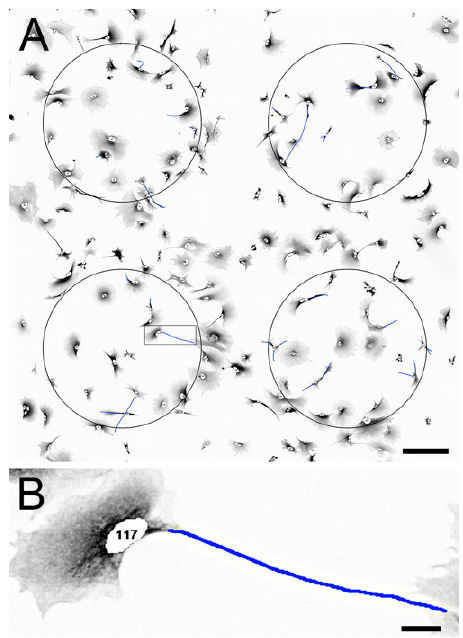
Figure A2. Grayscale image of the signal corresponding to the β -III tubulin channel of β -III tubulin and NeuN/Fox-3 doubly immunolabeled cells. Circles depict sampling areas (ROI). Traced neurites located with the NeuronJ plugin of ImageJ software are depicted in blue ( A ). ( B ) Detail of the framed area in ( A ). Scale bars: 200 µm in ( A ); 20 µm in ( B ).